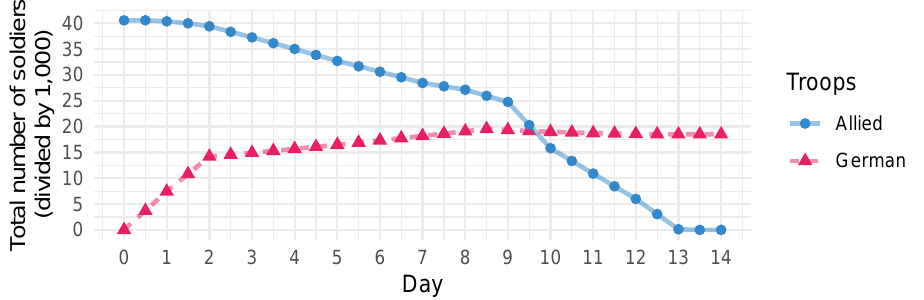
Figure 8. German and Allied troops evolution. As the German troops managed to transport enough units to defeat the garrison, Allied troops progressively lost the battle. Although the invasion was successful, there were heavy casualties among the German